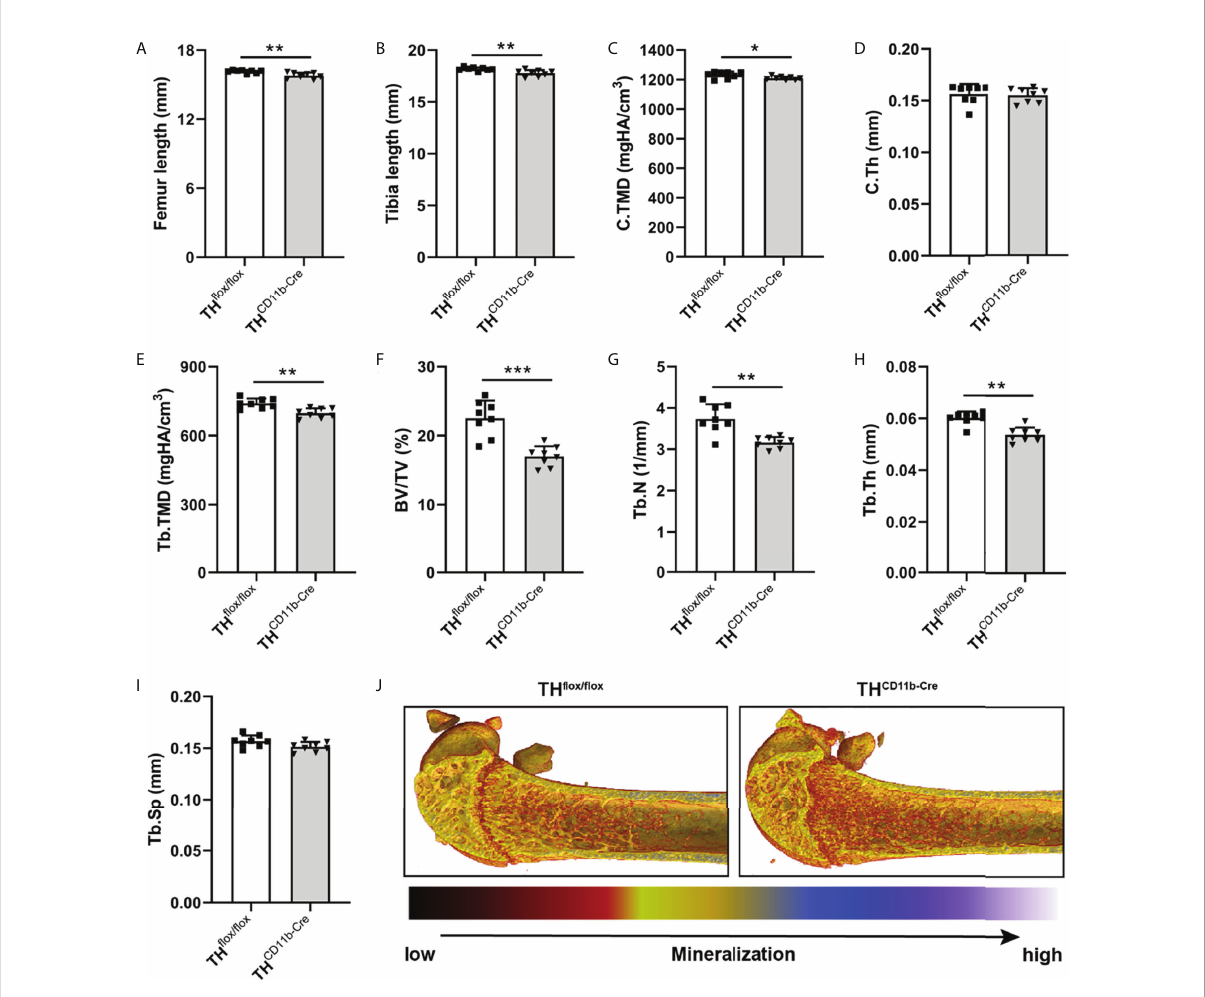
FIGURE 3 Bone phenotype of twelve-week-old TH CD11b-Cre mice. (A) Femur and (B) tibia length of twelve-week-old TH fl ox/ fl ox and TH CD11b-Cre mice. (C) Cortical tissue mineral density (C.TMD), (D) cortical thickness (C.Th), (E) trabecular tissue mineral density (Tb.TMD), (F) bone volume to tissue volume ratio (BV/TV), (G) trabecular number (Tb.N), (H) trabecular thickness (Tb.Th), (I) trabecular separation (Tb.Sp) and (J) representative µCT images of femora of twelve-week-old TH fl ox/ fl ox and TH CD11b-Cre mice. n = 8; *P < 0.05; **P < 0.01; ***P <